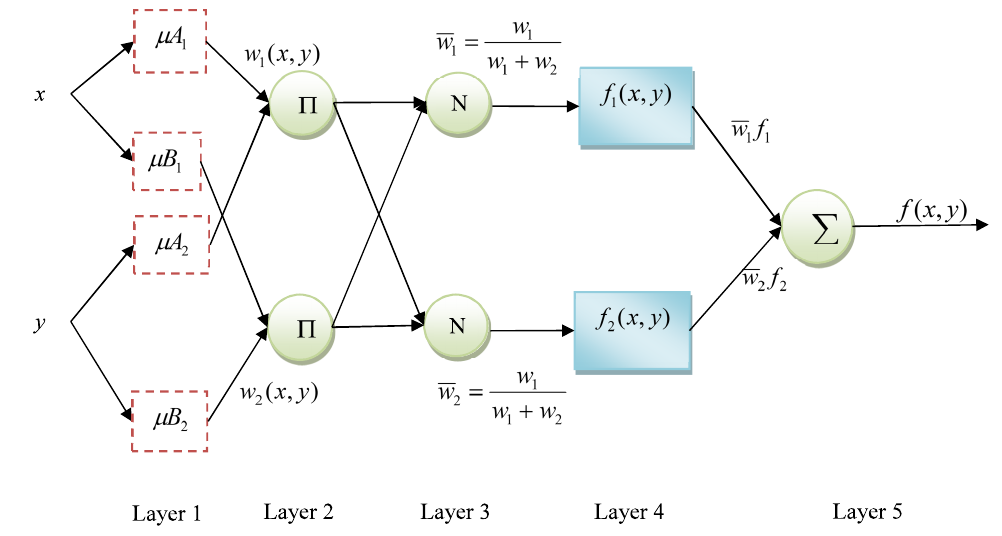
Figure 4. Architecture of adaptive neuro-fuzzy inference system in this